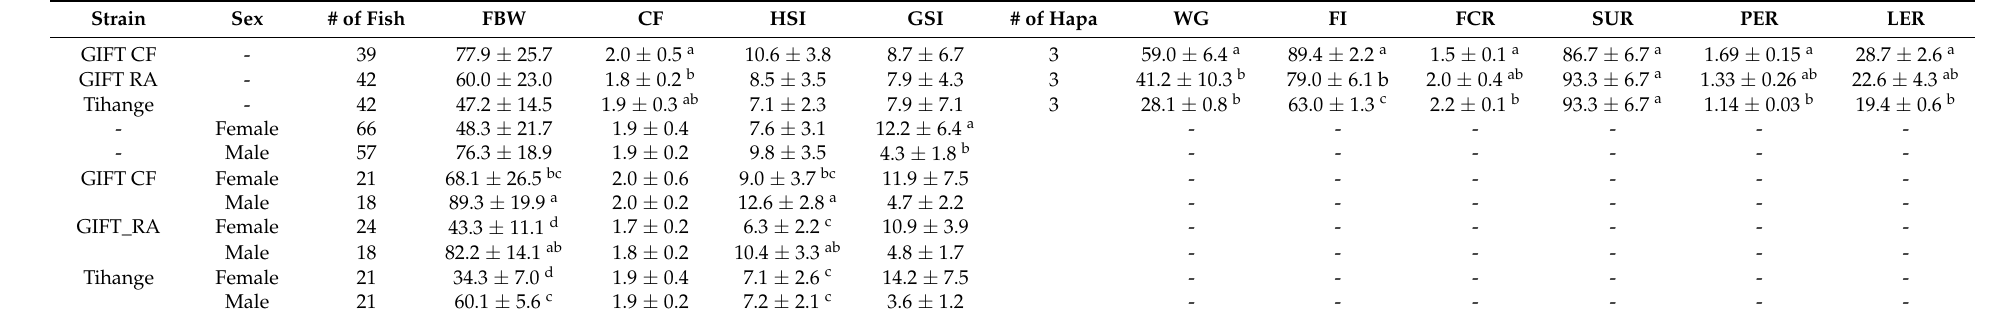
Table 6. Experiment 2 in Kinshasa, western lowlands DR Congo—mean ± standard deviation for fish and parameters for which there were individual values such as initial body weight (IBW), final body weight (FBW), condition factor (CF), hepato-somatic index (%) (HSI), gonado-somatic index (%) (GSI) organized by strain (GIFT-CF = GIFT Congo Futur, GIFT-RA = GIFT RATALBI, and Tihange) and sex (female and male); and parameters for which there were only mean values for hapas such as initial body weight (IBW), weight gain (WG), feed intake (FI), feed conversion ratio (FCR), survival rate (%) (SUR), protein efficiency ratio (PER), and lipid efficiency ratio (LER) organized by strain † .